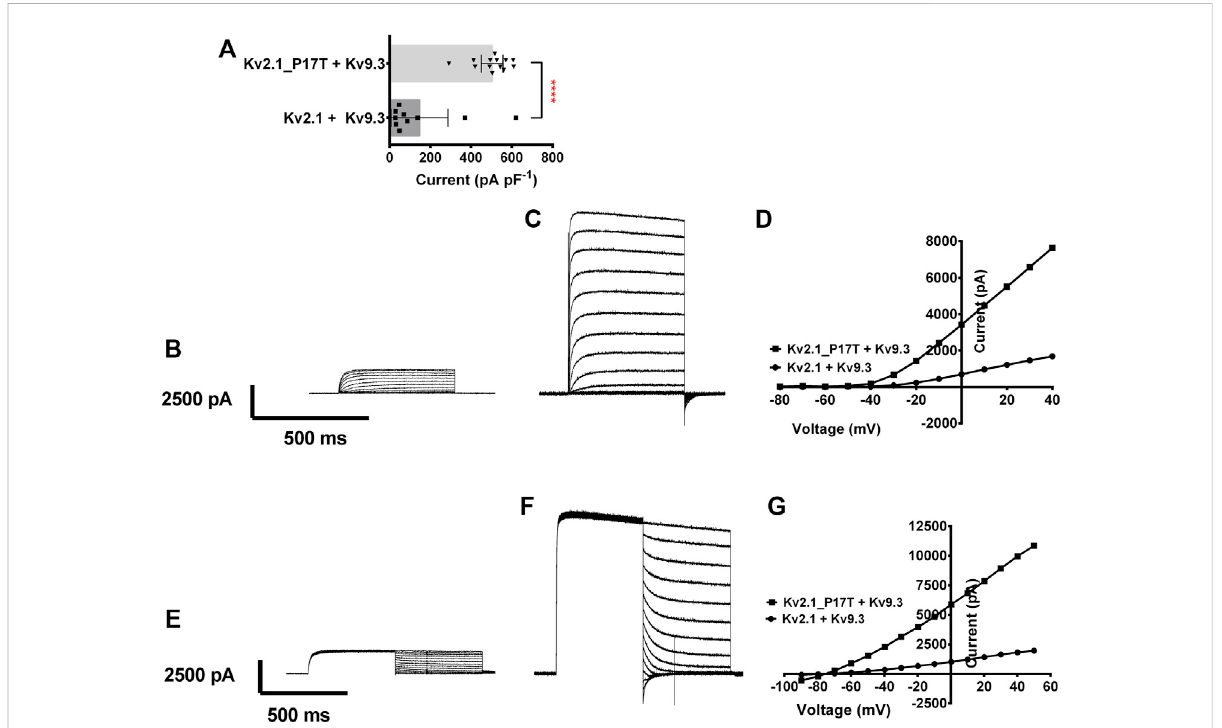
FIGURE 4 Coexpression of K V 2.1-WT and K V 2.1-P17T with K V 9.3 shows gain of function for heteromeric channels. (A) Histogram of current density (pA pF − 1 )measuredat+50 mVfromindividualcells,transientlyexpressing500 ngofK V 2.1-WT +K V 9.3(1:1, n =8),orK V 2.1-P17T+K V 9.3(1:1, n =6).Error bars represent 95% CI. Statistical signi fi cance was tested using a Student ’ s t test, p < 0.001 for ****. (B) Average whole-cell current trace recorded using protocol A when expressing 500 ng K V 2.1 + K V 9.3 (1:1). (C) Average whole-cell current trace recorded using protocol A when expressing K V 2.1-P17T + K V 9.3 (1:1). (D) Representative current voltage relationships for cells expressing K V 2.1-WT + K V 9.3 (1:1), or K V 2.1-P17T + K V 9.3 (1:1). (E) Average whole-cell current trace recorded using protocol B when expressing 500 ng Kv2.1 + K V 9.3 (1:1). (F) Average whole-cell current